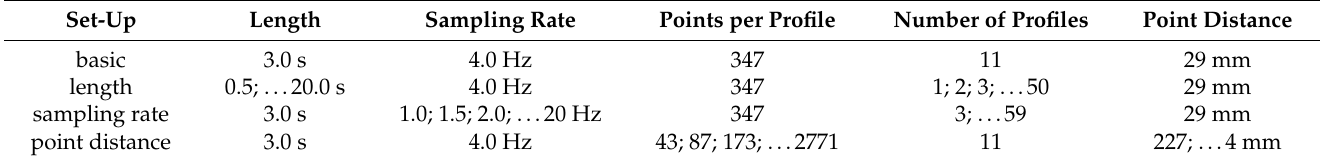
Table 2. Parameters of simulated